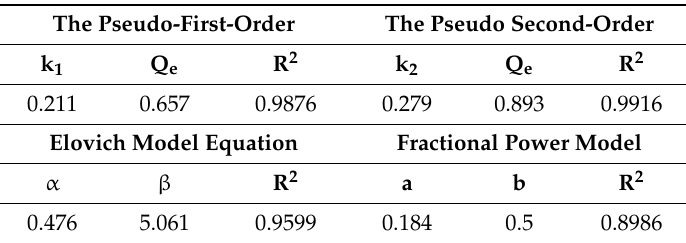
Table 7. Kinetic parameters for P adsorption on